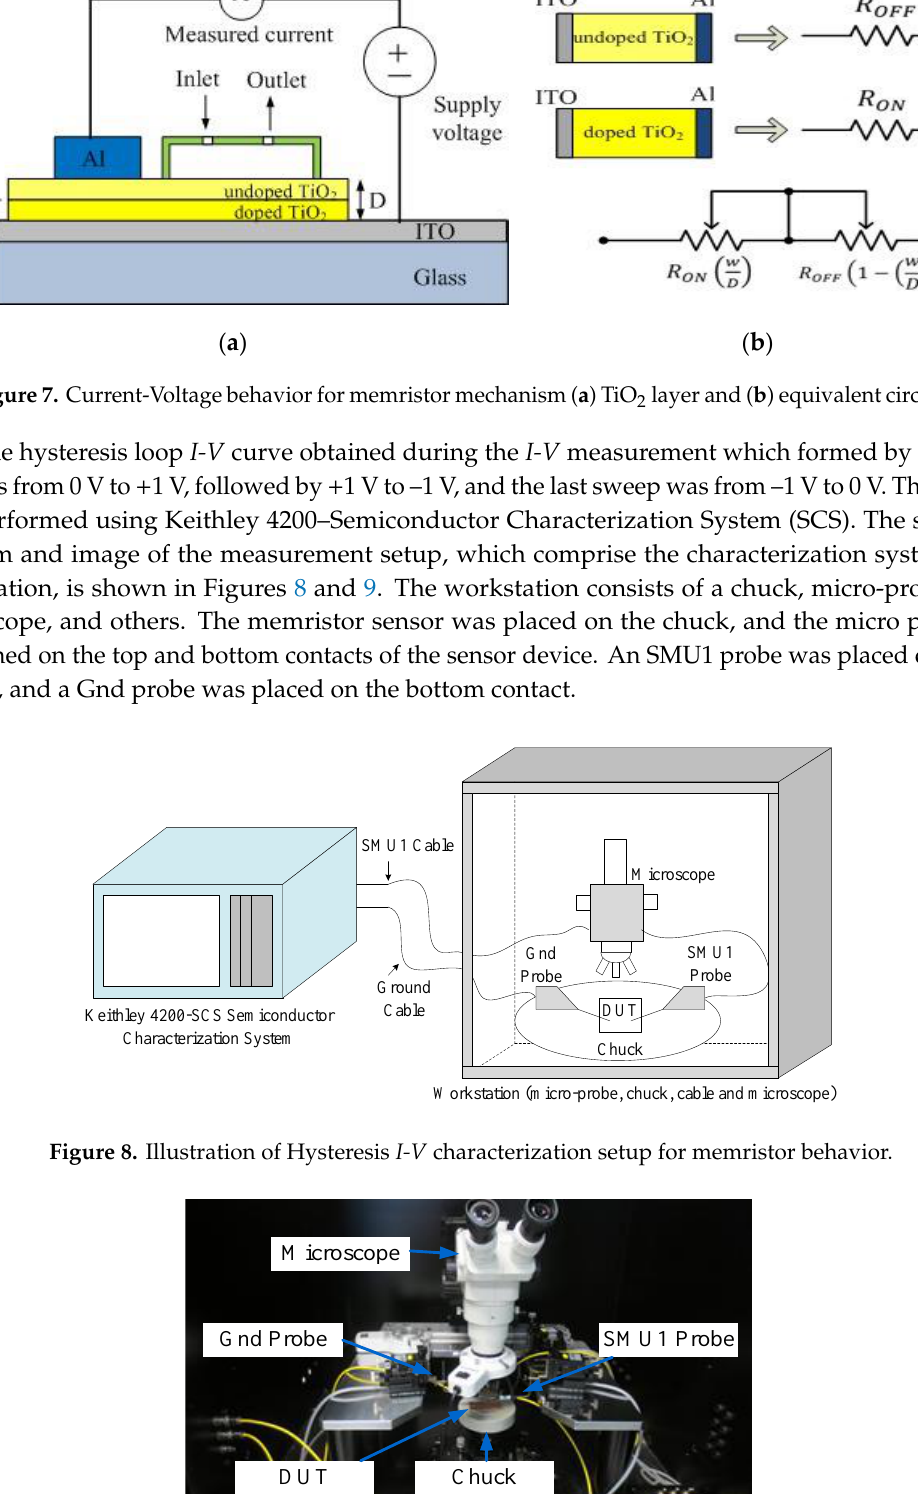
Figure 9. Photograph image of Hysteresis I-V characterization setup for memristor behavior.